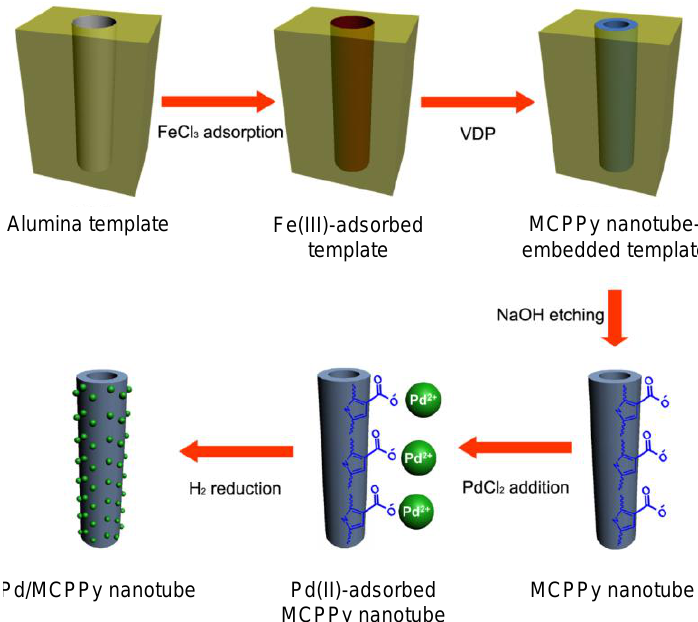
Figure 2. Schematic illustration of the fabrication of Pd nanoparticles-decorated MCPPy nanotubes. With permission from [22]; Copyright 2006, Wiley-VCH Verlag GmbH & Co. KGaA.